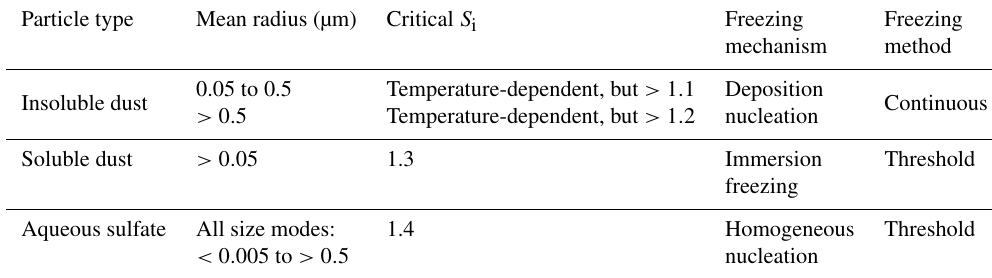
Table 1. Summary of the different aerosol species available for in situ ice nucleation within the cirrus scheme, including information on the average radius of the particles, the critical ice saturation ratio above which these particles will nucleate ice, the freezing mechanism by which nucleation will occur, and the freezing method within the context of the cirrus scheme following Muench and Lohmann (2020).